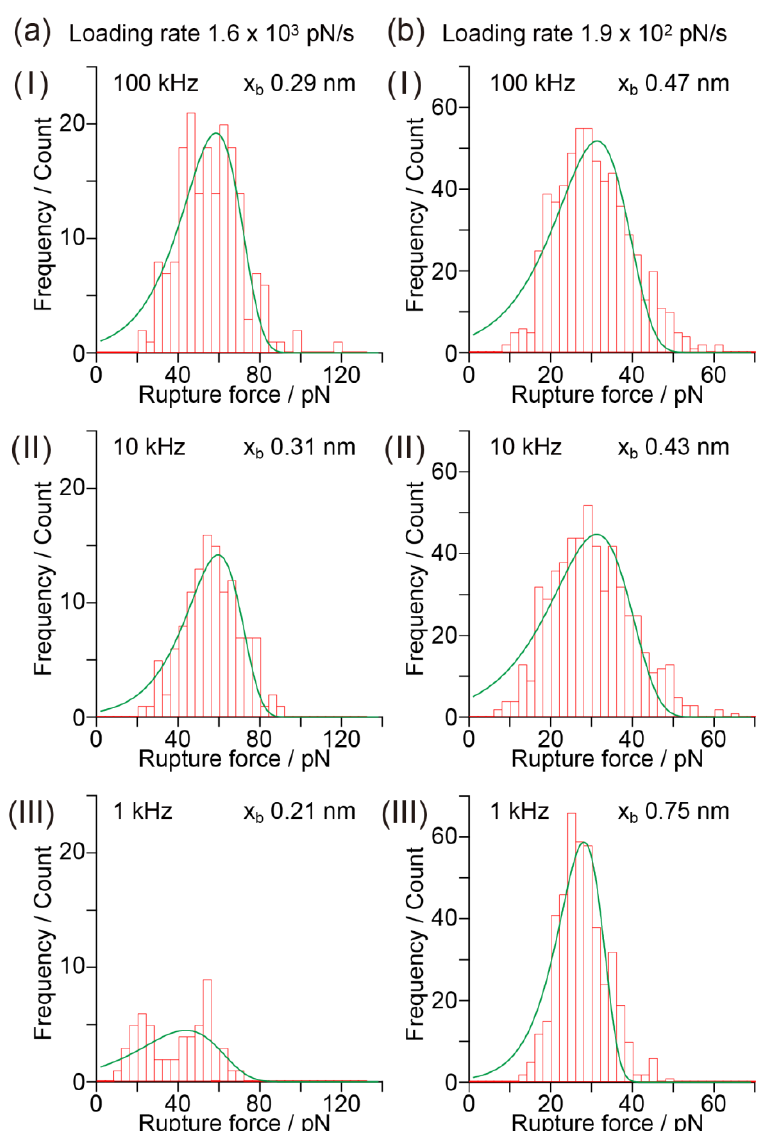
Figure 5. Histograms of the rupture force obtained for sampling rates of 100 kHz, 10 kHz and 1 kHz based on a series of data shown in Figure